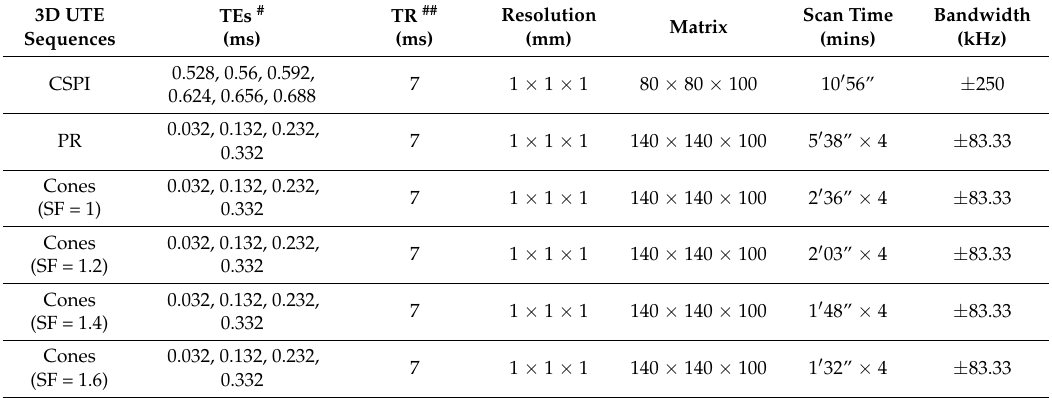
Table 1. Scan parameters of three types of ultrashort echo time (UTE) sequences and the Cones sequence with four different stretching factors (SFs) of 1.0, 1.2, 1.4, and